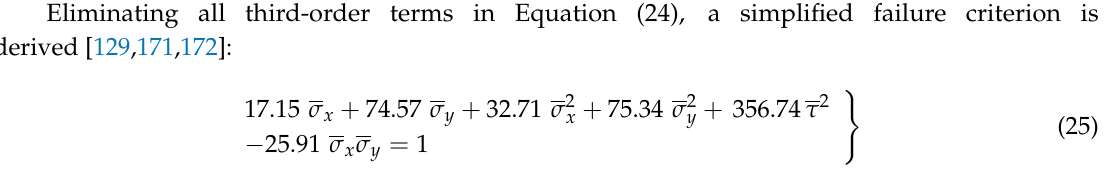
Figure 8. Von Mises modified isotropic failure criterion.